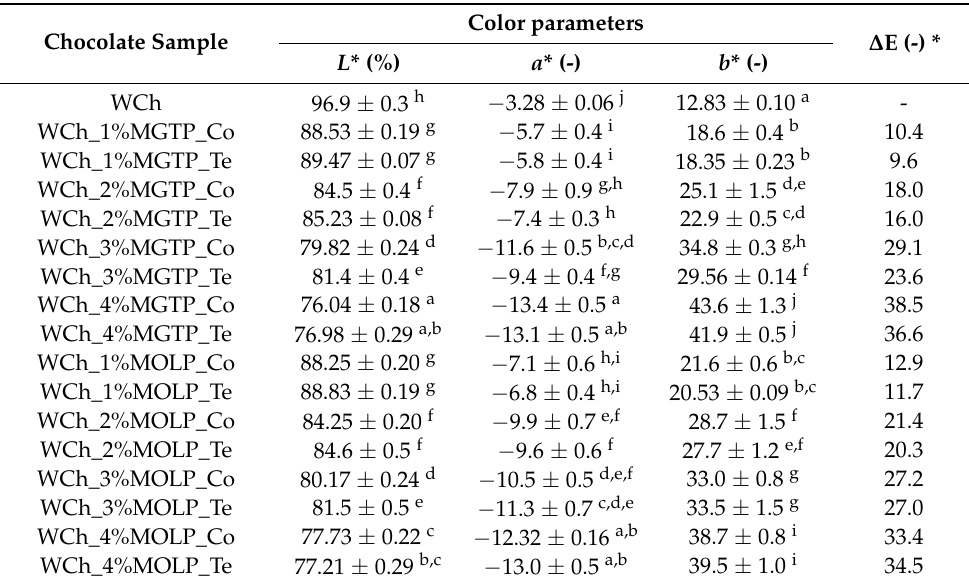
Table 8. Color parameters and total color difference ( ∆ E) of white chocolate with matcha green tea powder and moringa leaf powder added during conching and